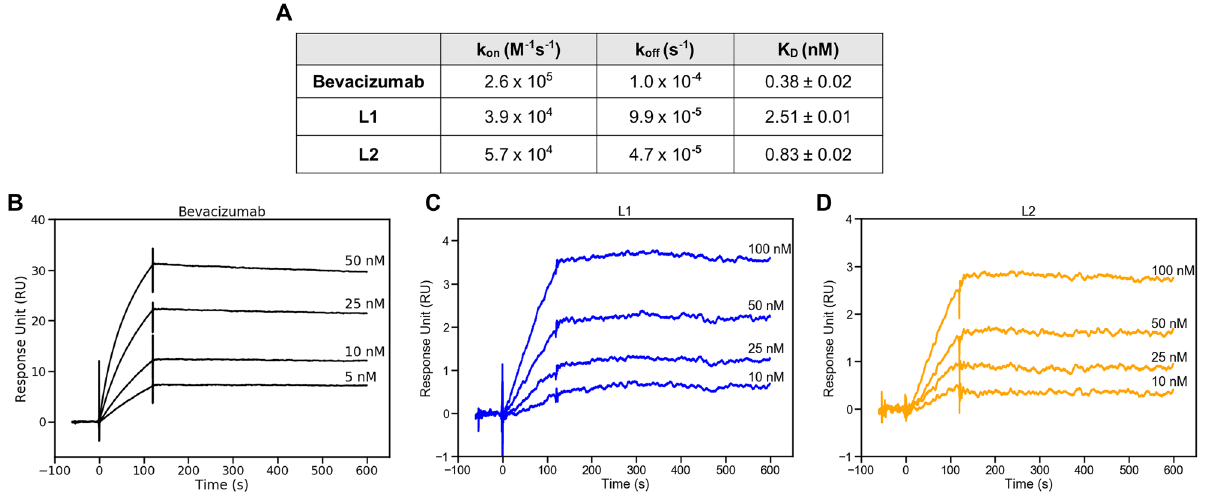
Figure 3. Binding kinetics of Bevacizumab, L1 and L2 fragments to their antigen, VEGF. ( A ) Obtained kinetic parameters. Sensogram overlays for ( B ) bevacizumab ( C ) L1 and ( D ) L2. Antibody concentrations are expressed on corresponding curves. Analyses were repeated 2